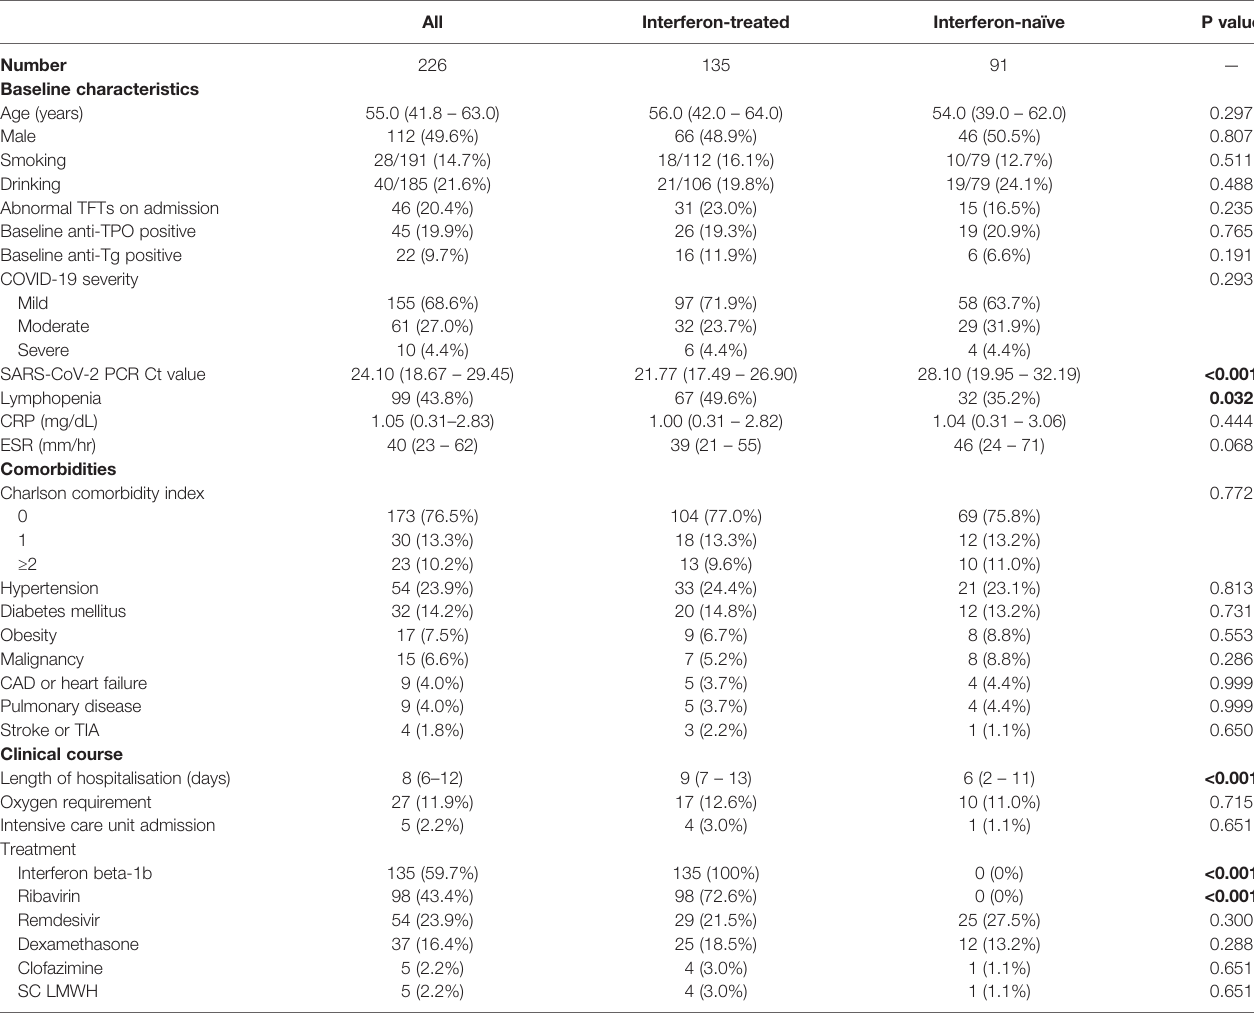
TABLE 1 | Baseline characteristics of the cohort (n = 226).